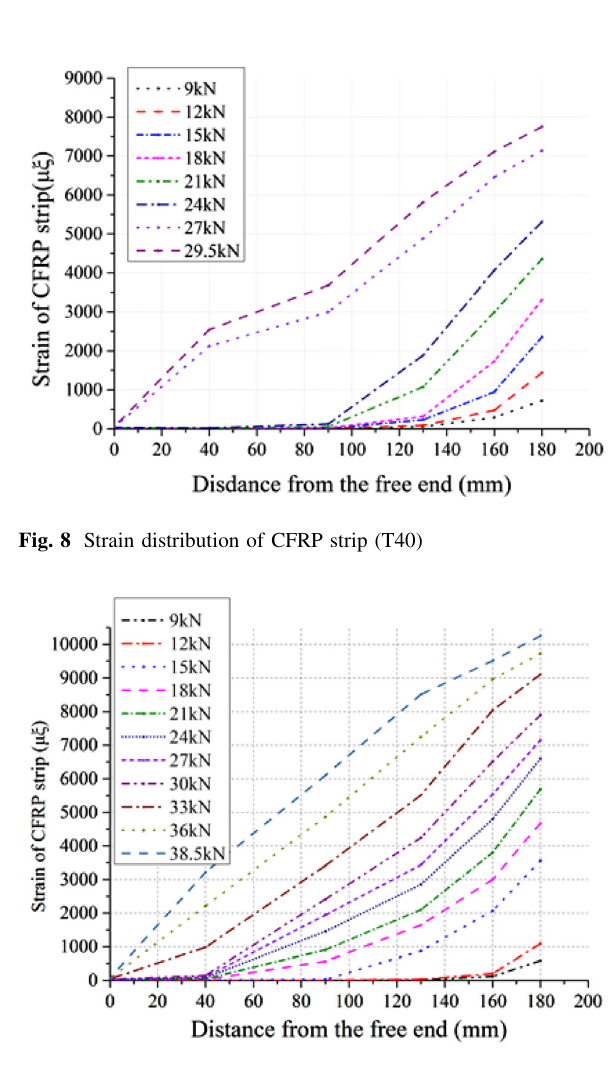
Fig. 9 Strain distribution of CFRP strip (T50)